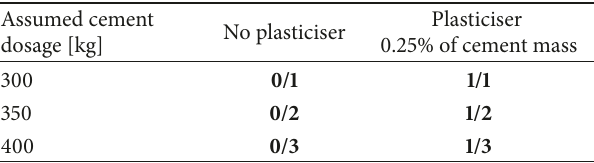
Table 1: Identification of test